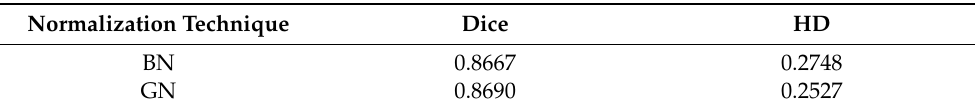
Table 3. The comparison of Dice score and HD score in esophagus segmentation between using BN and GN in our proposed method. All values are computed from the test set of SegTHOR challenge by online website https://competitions.codalab.org/competitions/21145 (accessed 28 May 2021). Normalization Technique Dice HD BN 0.8667 0.2748 GN 0.8690